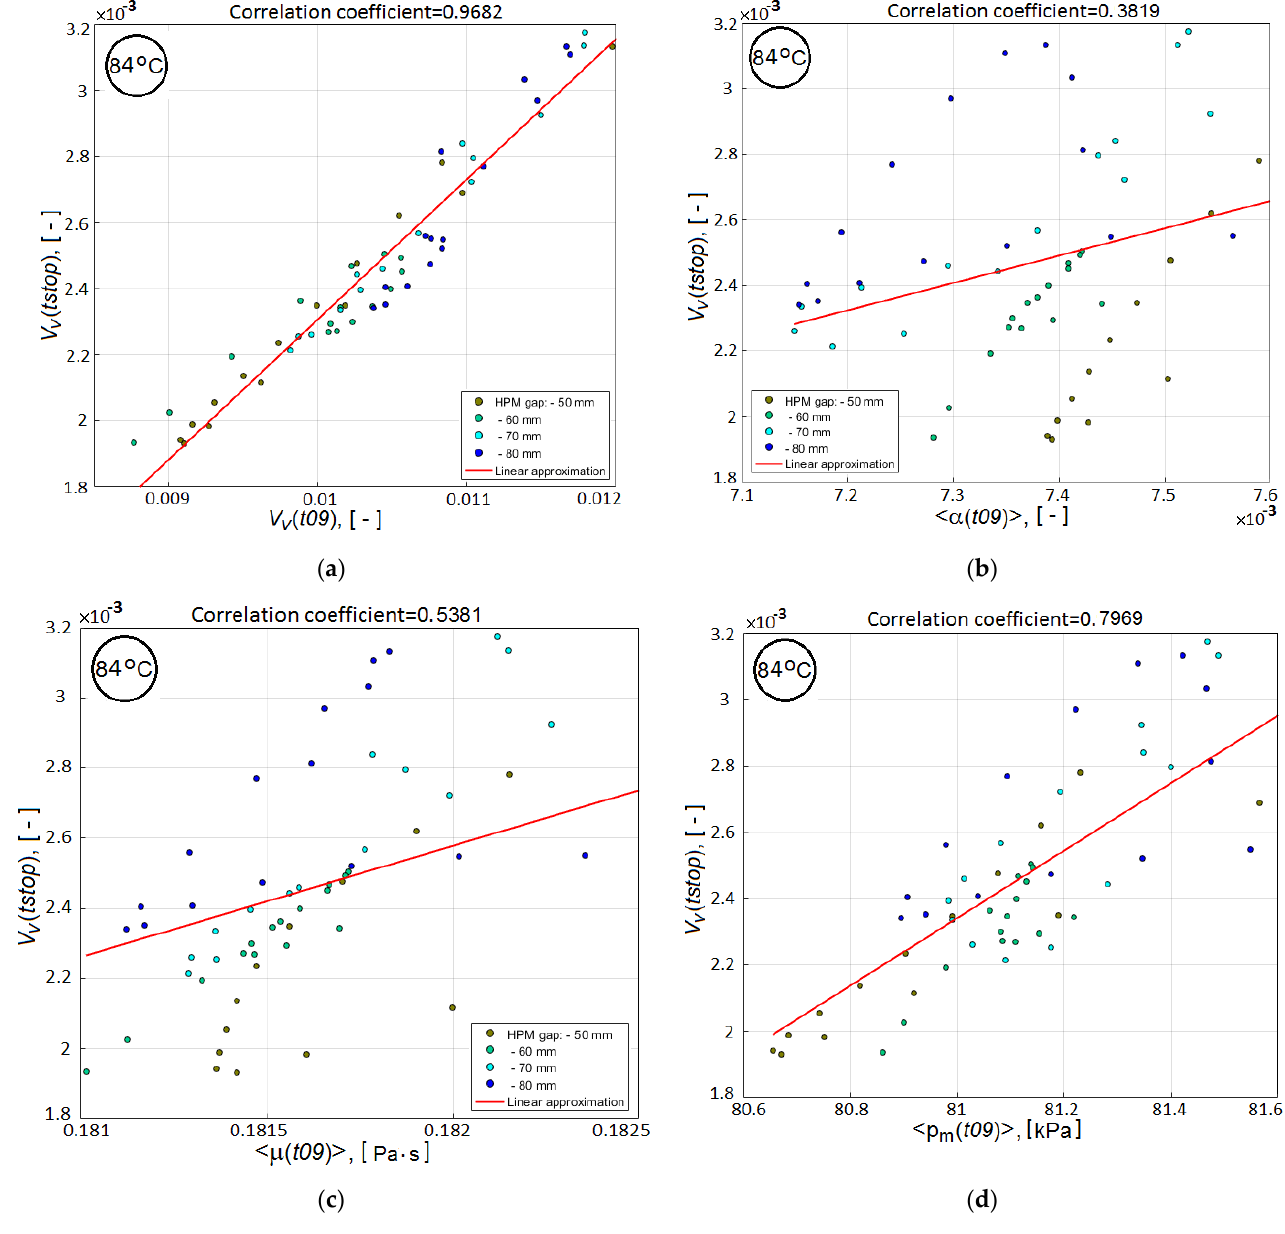
Figure 7. 2D scatter plots showing the correlation between the main quality criterion at the end of the resin infusion and the sub-criteria, which are calculated at time instant t 09: ( a ) relative void volume V v ( t 09); ( b ) averaged degree of cure < α ( t 09)>; ( c ) averaged viscosity < µ ( t 09)> and ( d ) averaged pressure < P m ( t 09)> in partially filled